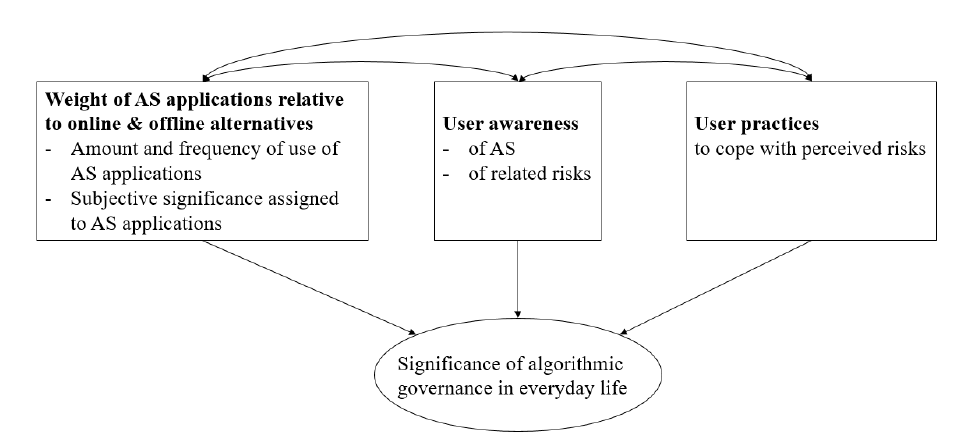
Figure 1: Theoretical model of variables measuring the significance of algorithmic governance in everyday